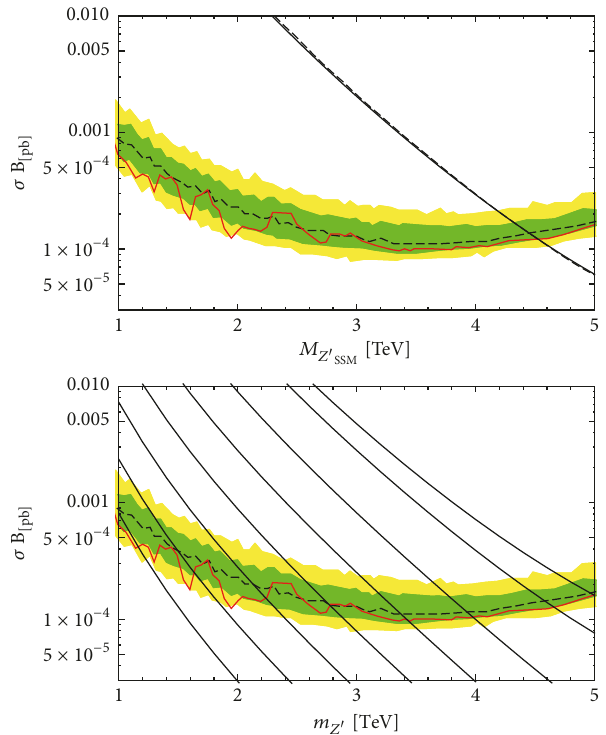
Figure 5: Top panel: the cross section as a function of the 𝑍 耠 푆푆푀 mass (solid line) with 𝑘 = 1.31 , along with the ATLAS result in [68] from the combined dielectron and dimuon channels. Bottom panel: the cross sections calculated for various values of 𝛼 퐵−퐿 with 𝑘 = 1.31 . The solid lines from left to right correspond to 𝛼 10 −5 , 10 −4.5 ,10 −4 , 10 −3.5 ,10 −3 , 10 −2.5 ,10 −2 , and 10 −1.8 ,